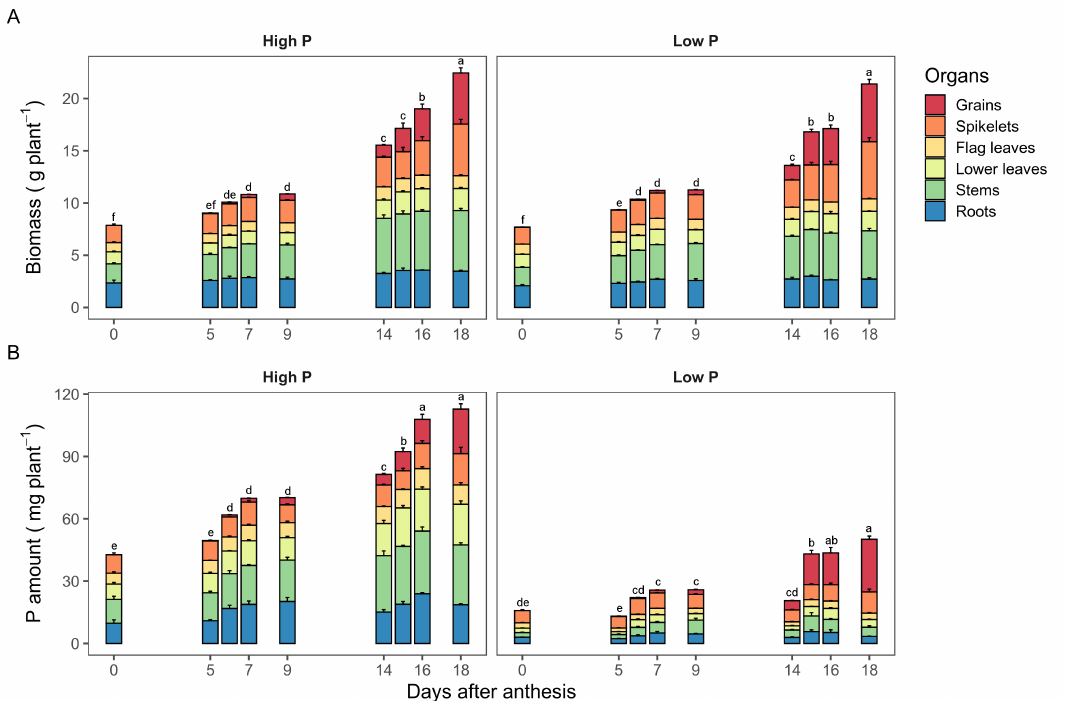
Figure 1. Biomass ( A ) and P amount ( B ) in different organs of durum wheat grown under high and low P supplies. Values are mean ± standard errors of three replicates. Different letters indicate significant differences between days for total biomass or P amount according to the LSD test at p